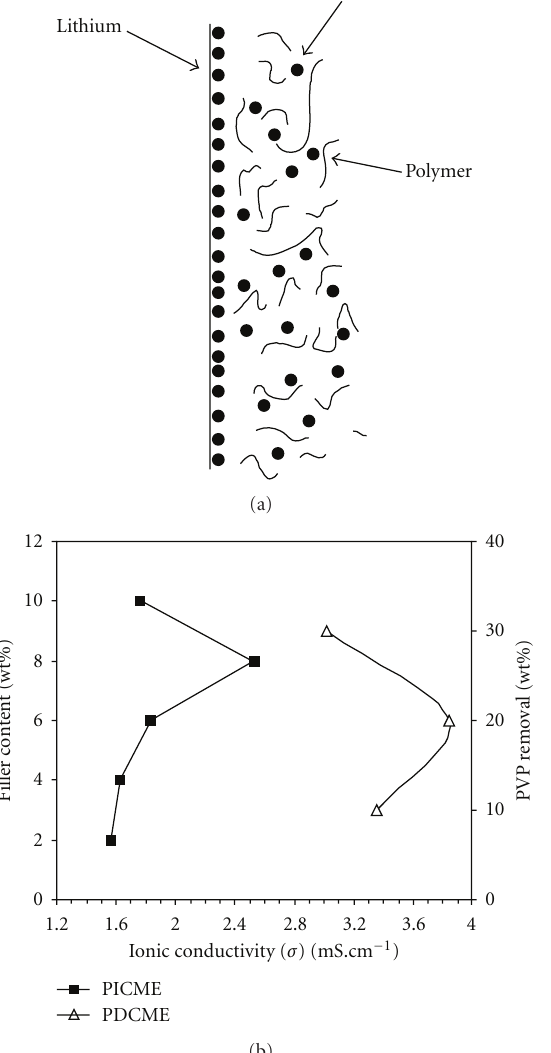
Figure 4: (a) The schematic representation of composite polymer electrolyte with the inert filler of nanosized particle (b) Ionic conductivity of (a) PICMEs and (b) PDCMEs at 25 ◦ C.